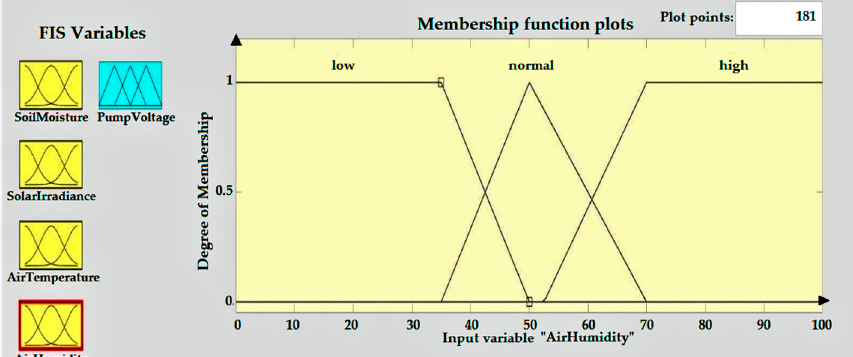
Figure 6. Air humidity membership function plot.